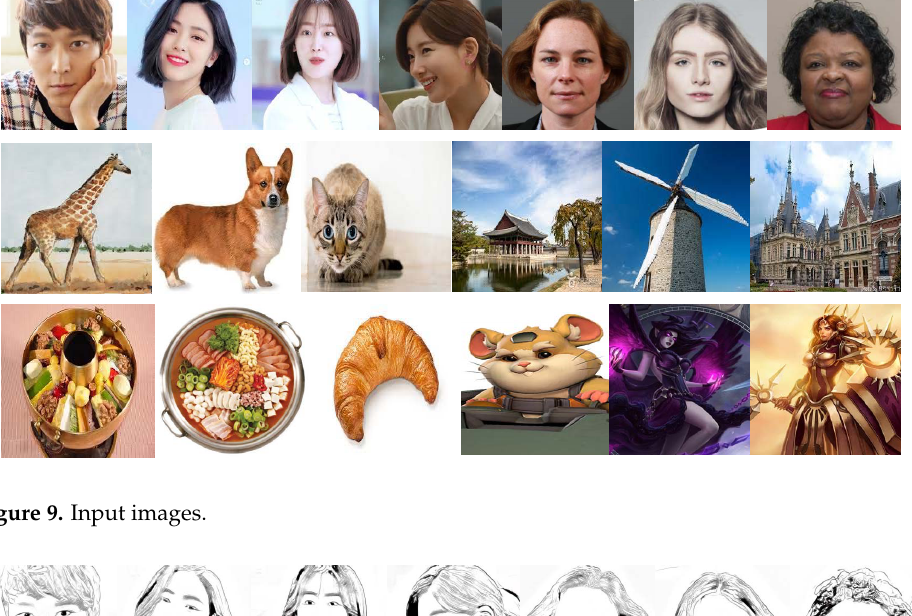
Figure 9. Input images.